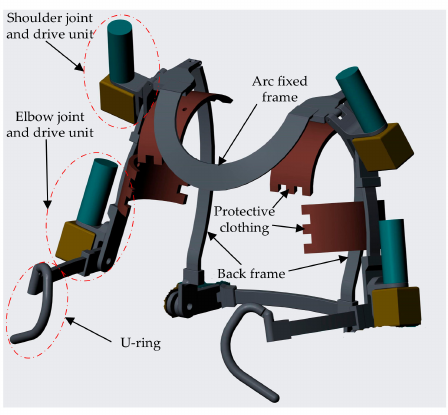
Figure 2. The overall mechanical structure of upper limb